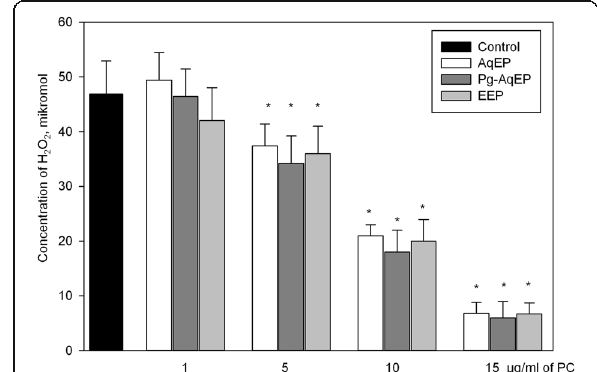
Fig. 1 Effect of propolis extracts on H 2 O 2 concentration in cell culture medium. Different concentrations (1 – 15 μ g/ml PC) of AqEP, Pg-AqEP and EEP were added to wells filled with HBSS and enriched with 50 μ M H 2 O 2 . Immediately before measurement horseradish peroxidase and Amplex Red dye were added and fluorescence intensity were measured. Data are presented as means of percentage of the control cells ± SE ( n =5). * p <0.05 versus